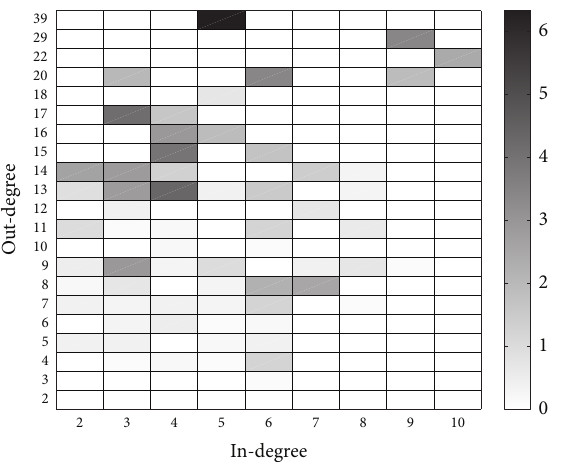
Figure 8: Differences between the results for 𝑢 𝑖,𝑗 from simulations and theoretical